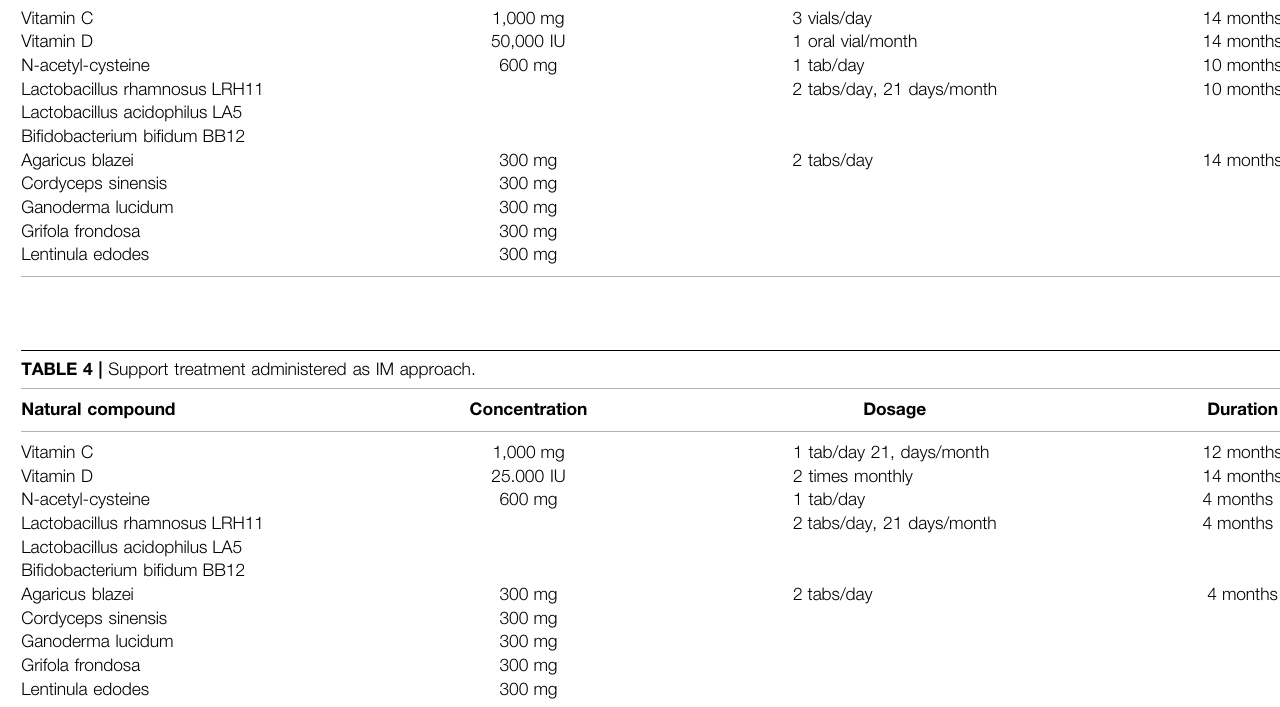
TABLE 3 | Support treatment administered as an IM approach. Natural compound